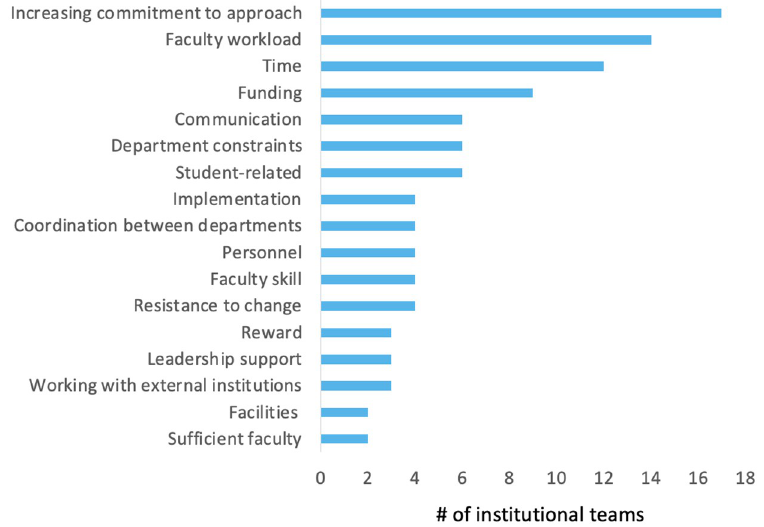
Fig 10. Barriers identified on progress-to-date posters presented at the NW BIO conference (n = 36 posters with barriers data).